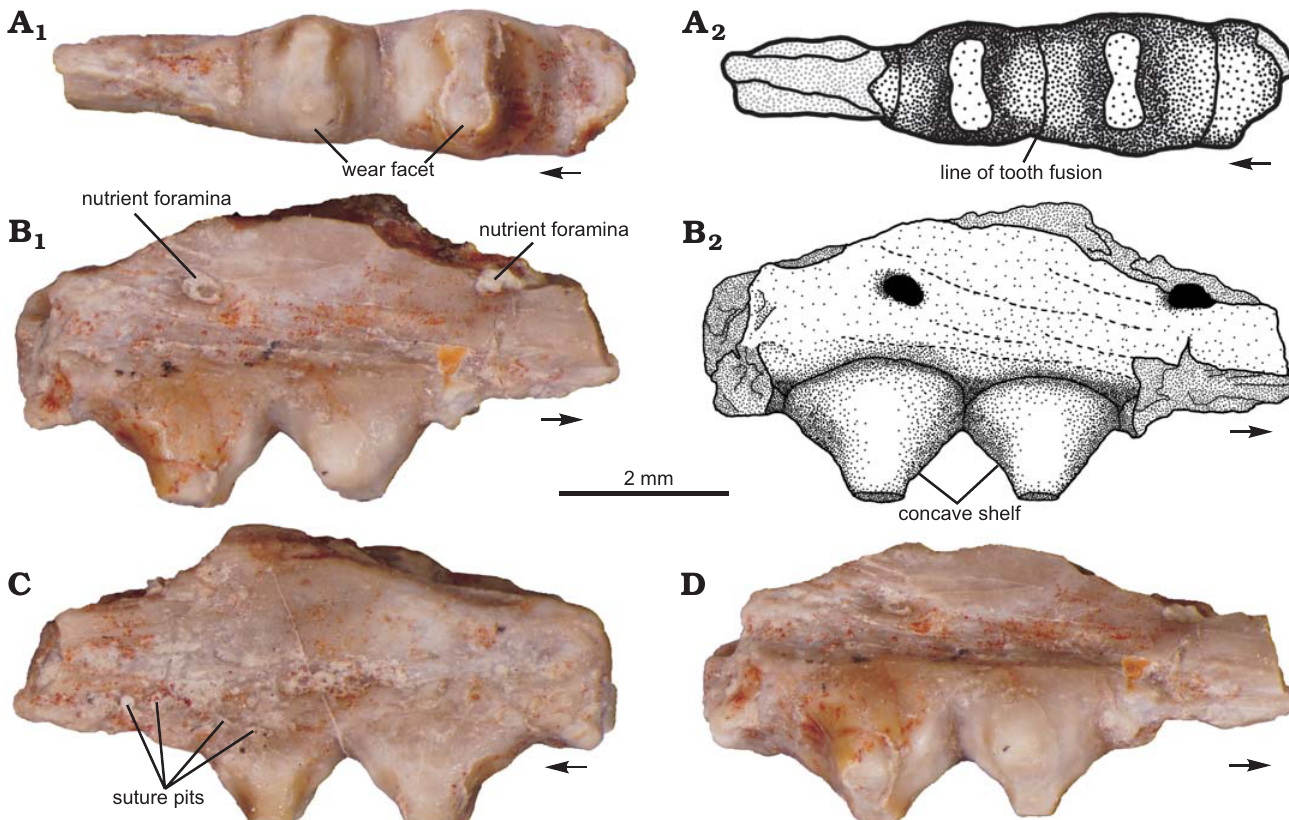
Fig. 2. Diapsid Palacrodon browni Broom, 1906 (PEFO 37247) from Norian, Petrified Forest National Park, Arizona, USA; in occlusal ( A ), labial ( B ), lingual ( C ), and oblique ( D ) views. Arrows point in anterior direction. Photographs (A 1 , B 1 , C, D), explanatory drawings (A 2 , B 2